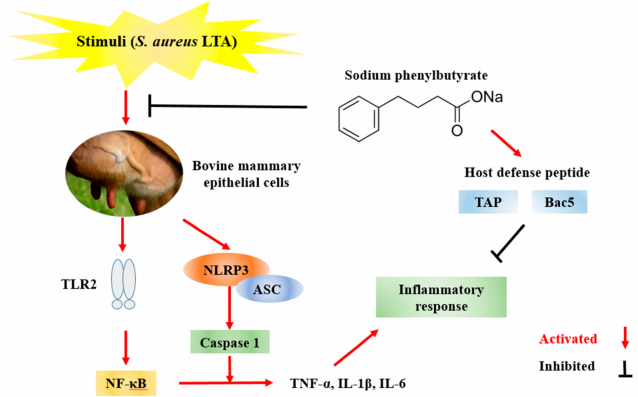
Figure 6. Schematic representation of protective effects of SPB against Staphylococcus aureus LTA-induced cell inflammatory responses in MAC-T